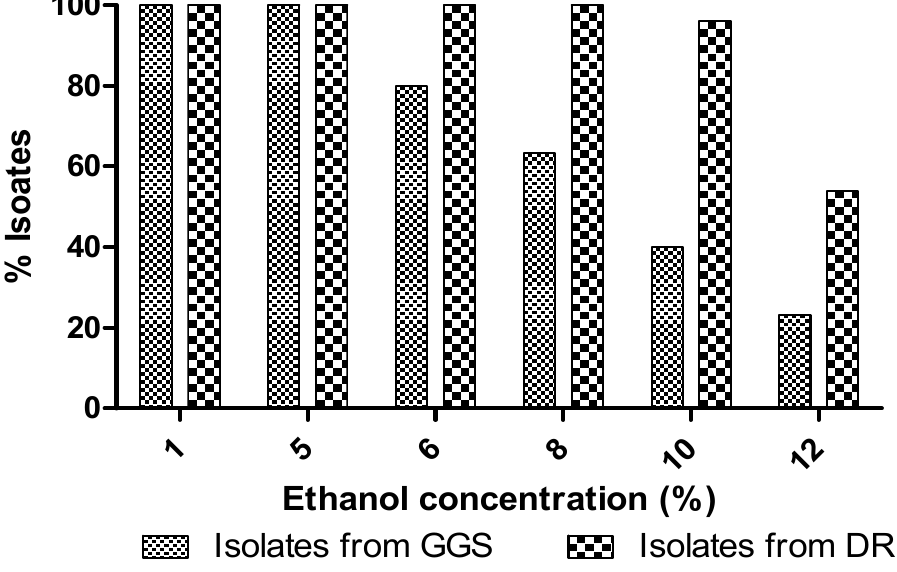
Figure 3. Effect of temperature on the growth of yeast isolates.